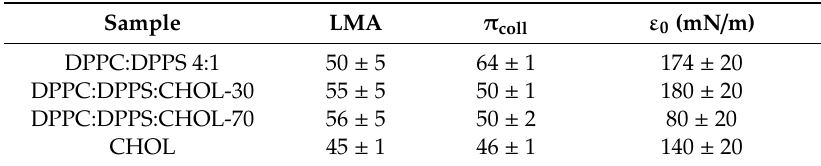
230 ± 15 Table 4. Limiting molecular area LMA, collapse pressure ( π coll ), and maximum Gibbs elasticity ( ε 0 ) values of DPPC:DPPS:CHOL monolayers spread onto MgCl 2 5 mM (Figure 1C). Sample π coll